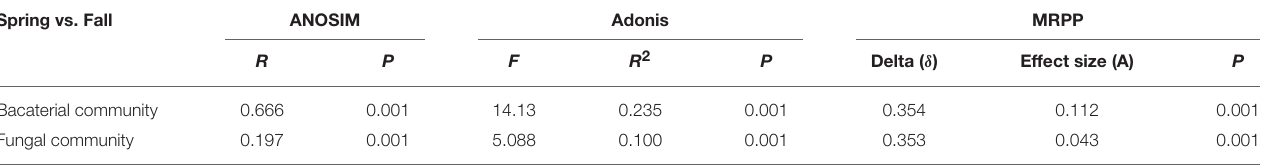
TABLE 3 | Dissimilarity comparison of soil microbial communities structure between spring and fall cropping seasons. Spring vs. Fall ANOSIM Adonis MRPP